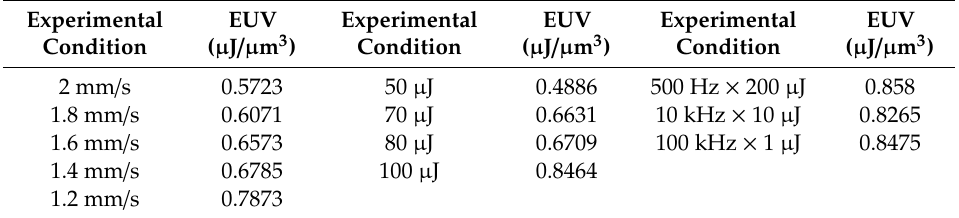
Figure 11. Schematic diagram of fs laser direct writing to produce a single line, where l is the length of the single line, which is equal to the side length of the sample (10 mm), and V is the volume removed by fs laser ablation, which can be directly extracted from the WL interferometer results. Table 3. Experimental parameters and their corresponding EUV (energies applied to unit volume).